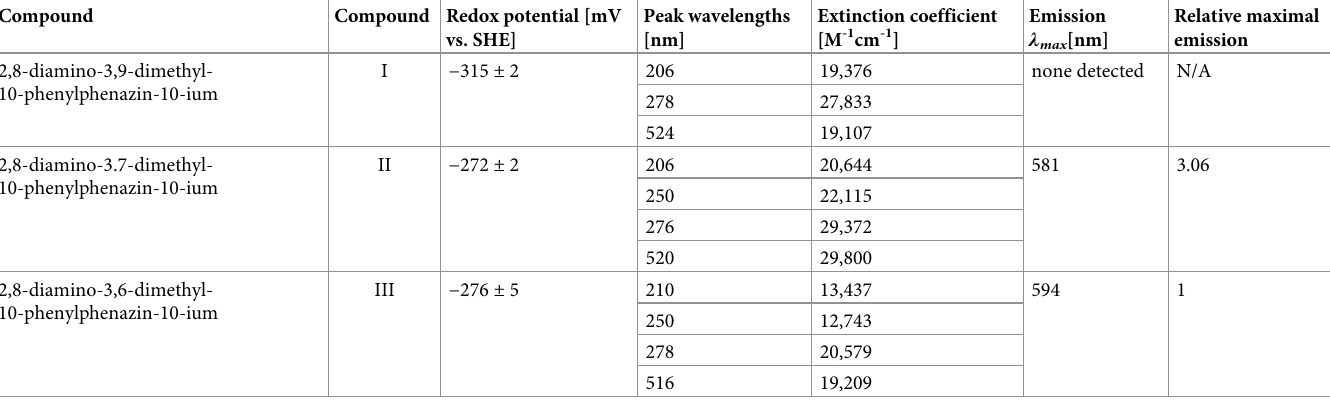
Table 1. Safranine O components and their properties. Compound